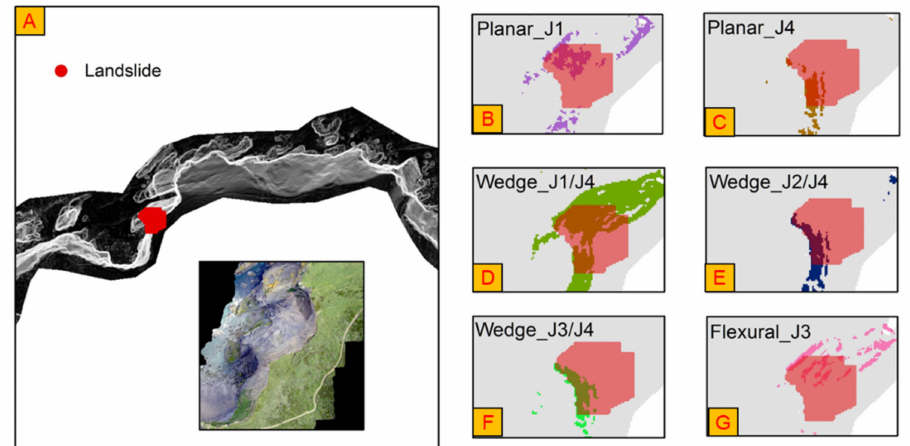
Figure 11. Results of GIS-based kinematic analysis and their comparison with a catastrophic landslide at Hell’s Mouth, ( A ) the extent of the Hell’s Mouth landslide, ( B ) potential planar failures caused by J1, ( C ) potential planar failures caused by J4, ( D ) potential wedge failures caused by J1/J4, ( E ) potential wedge failures caused by J2/J4, ( F ) potential wedge failures caused by J3/J4, ( G ) potential flexural toppling failures caused by